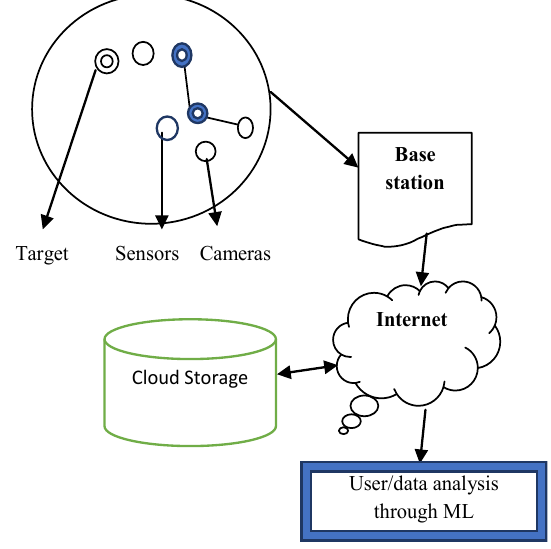
Figure 1. Basic architecture of intelligent surveillance